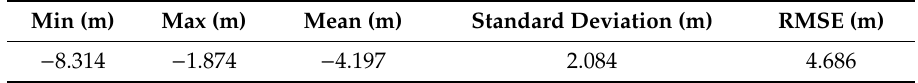
Figure 14. The islands of Procida (right) and Ischia (left) are shown here in the datum WGS84 (in brown) and in the datum ED50 (in yellow). The shift between the datum is evident. Table 13. Statistical values of the residuals for the East coordinates resulting from datum transformation UTM / ED50 to UTM / WGS84 based on automatic QGIS application.